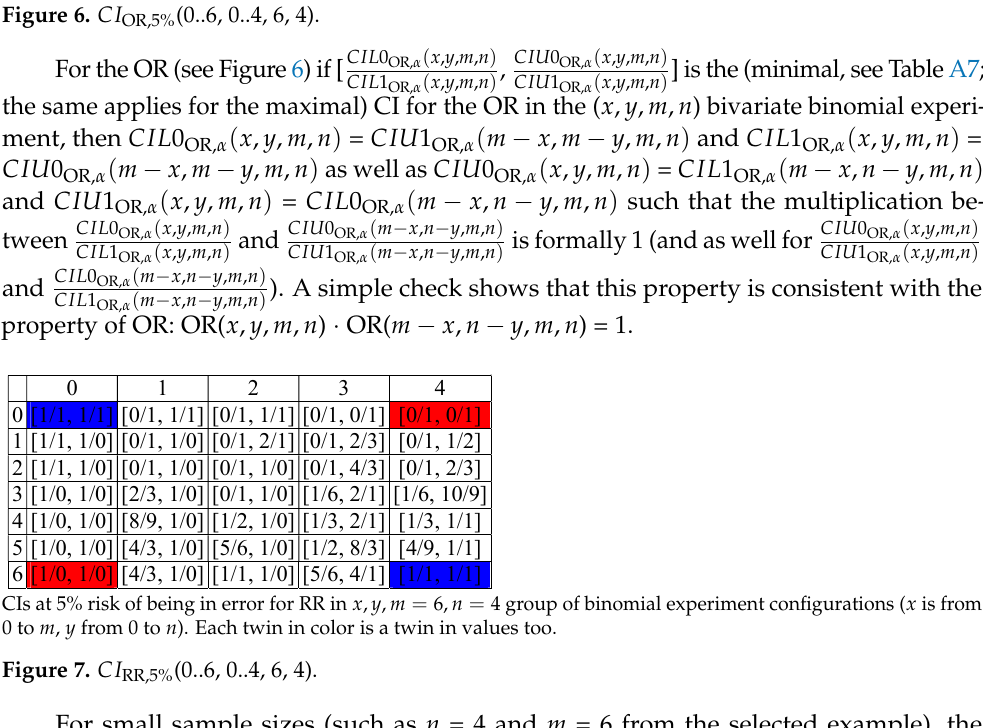
ranging from 0 to m and y from 0 to n ). Each twin in color is a twin in values as well.